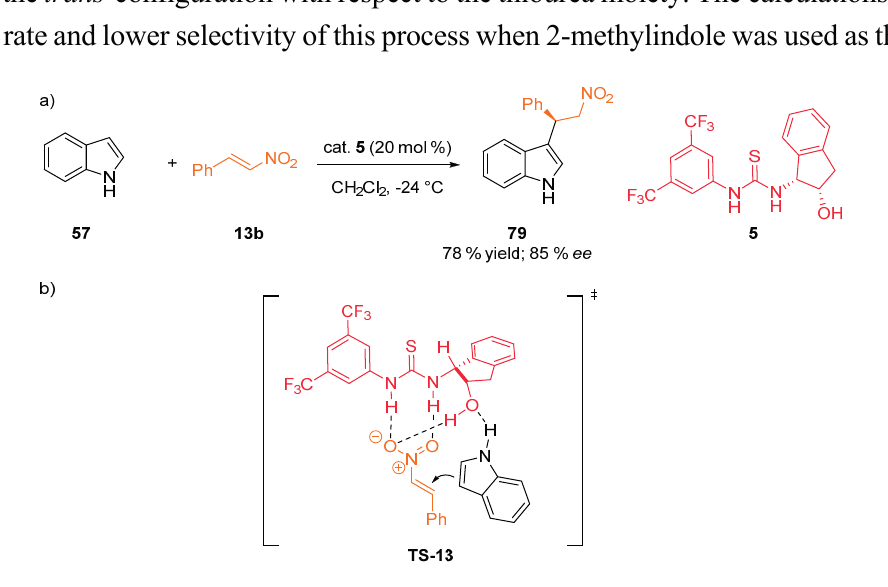
Figure 20. Friedel-Crafts alkylation of indole ( 57 ) ( a ); calculated transition state ( b ).